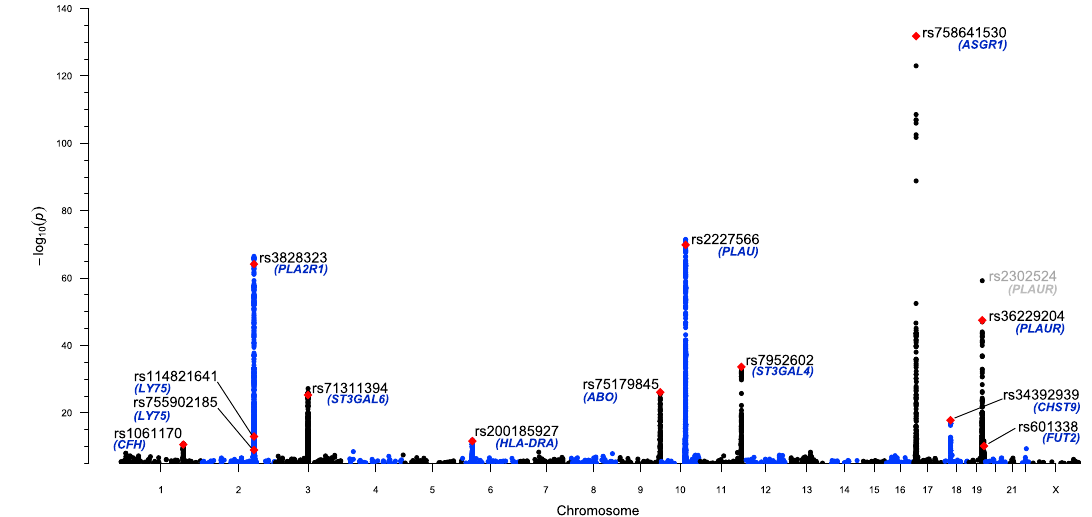
Fig. 1 suPAR GWAS meta-analysis Manhattan plot ( N = 47,736), showing the 11 genome-wide signi fi cant loci and the 13 independently signi fi cant variants associated with suPAR. The negative log10 transformed P values for variants are plotted by chromosomal location. Y axis begins at P = 1 × 10 − 5 . Red points signify the 13 independently signi fi cant variants associated with suPAR, with variant IDs annotated in black and the corresponding gene annotated in